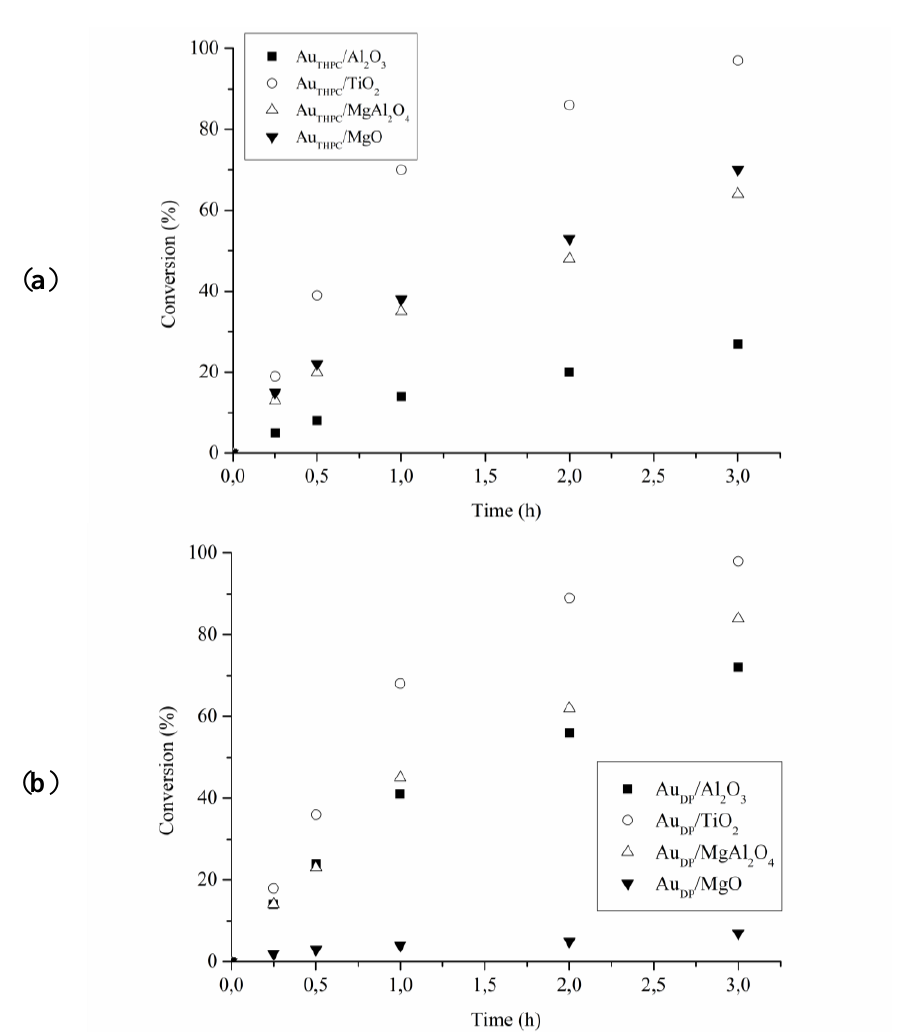
Figure 4. Reaction profiles for ethylene glycol oxidation using ( a ) Au ( b ) Au DP